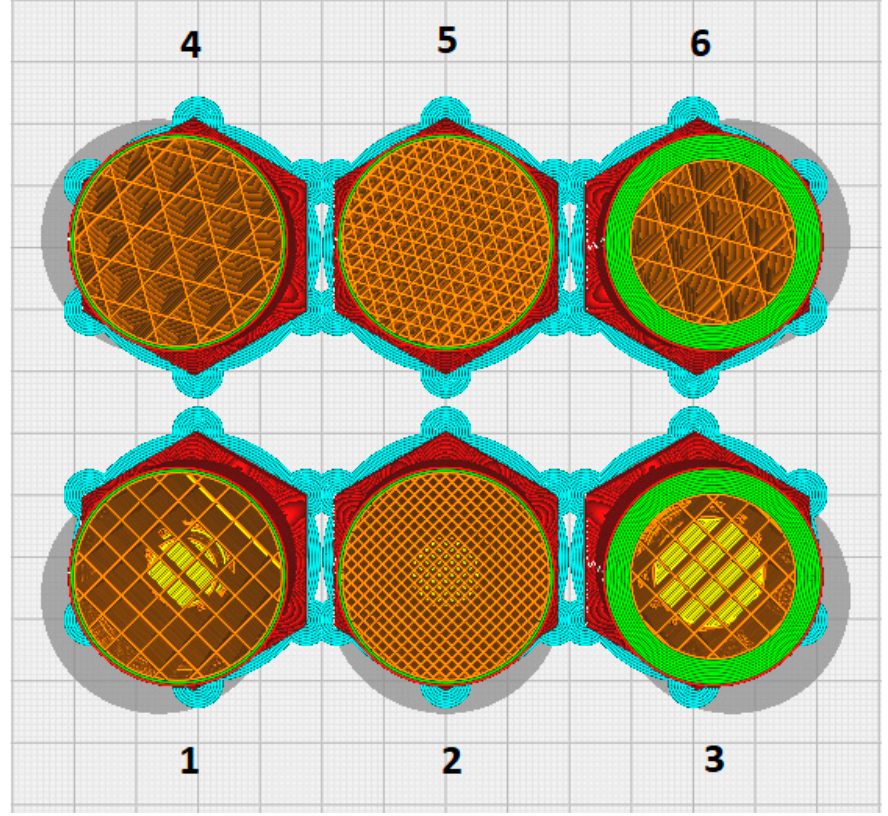
Figure 5. Punch settings of Test 1.